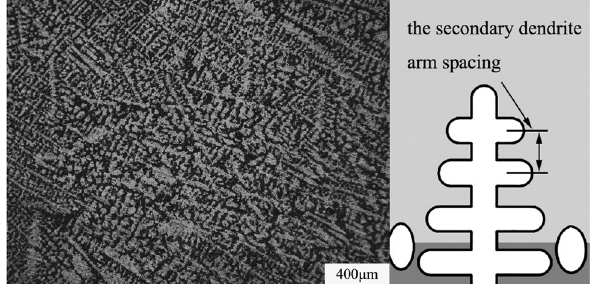
Figure 12: Dendritic morphology at the edge of as - cast steel and sketch map of the secondary dendrite arm